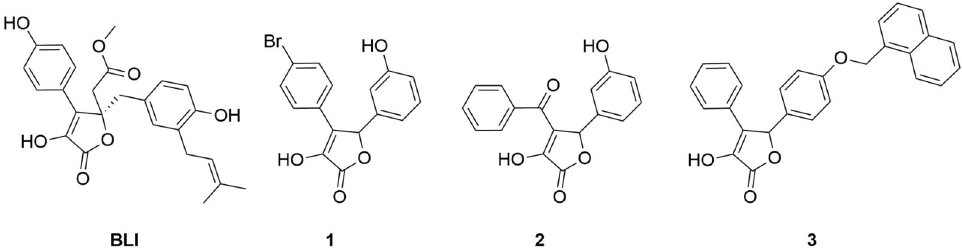
Figure 2. Chemical structures of BLI, 4 ‐ (4 ‐ bromophenyl) ‐ 3 ‐ hydroxy ‐ 5 ‐ (3 ‐ hydroxyphenyl)furan ‐ 2(5 H ) ‐ one ( 1 ), 4 ‐ benzoyl ‐ 3 ‐ hydroxy ‐ 5 ‐ (3 ‐ hydroxyphenyl)furan ‐ 2(5 H ) ‐ one ( 2 ) and 3 ‐ hydroxy ‐ 5 ‐ (4 ‐ (naphthalen ‐ 1 ‐ ylmethoxy)phenyl) ‐ 4 ‐ phenylfuran ‐ 2(5 H ) ‐ one ( 3